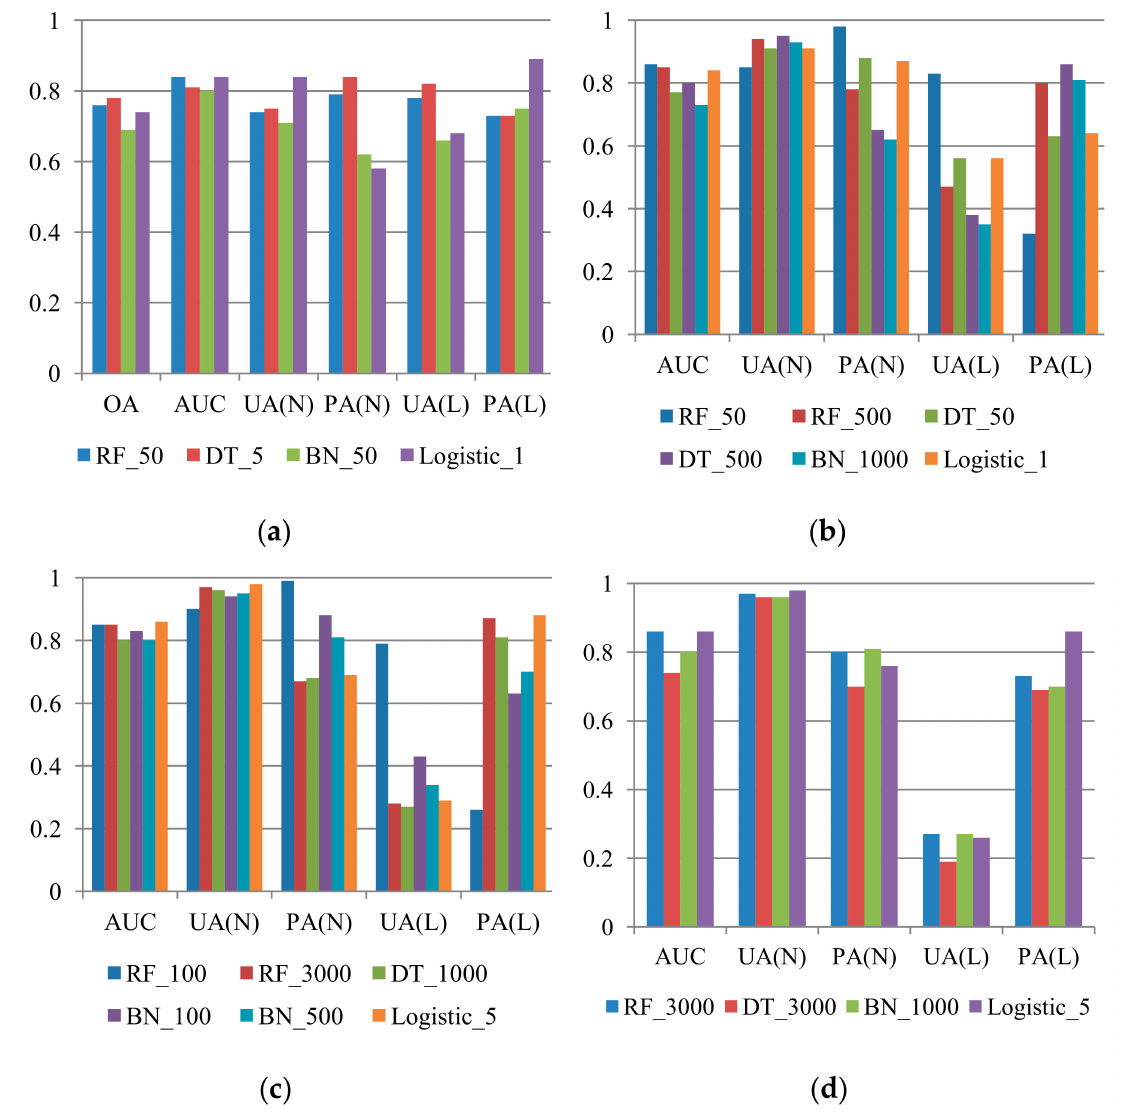
Figure 8. Comparison of the representative results ( Y axis: accuracies) of Typhoon Sinlaku prediction using the RF, DT, BN, and logistic algorithm with cost-sensitive analysis, where RF, DT, BN, OA, UA, PA, AUC, L, and N indicate random forests, decision tree, and Bayes network algorithm, overall accuracy, user’s accuracy, producer’s accuracy, area under ROC curve, landslide class, and non-landslide class, respectively.( a ) L:N = 1:1; ( b ) L:N = 1:4; ( c ) L:N = 1:7; ( d ) L:N =